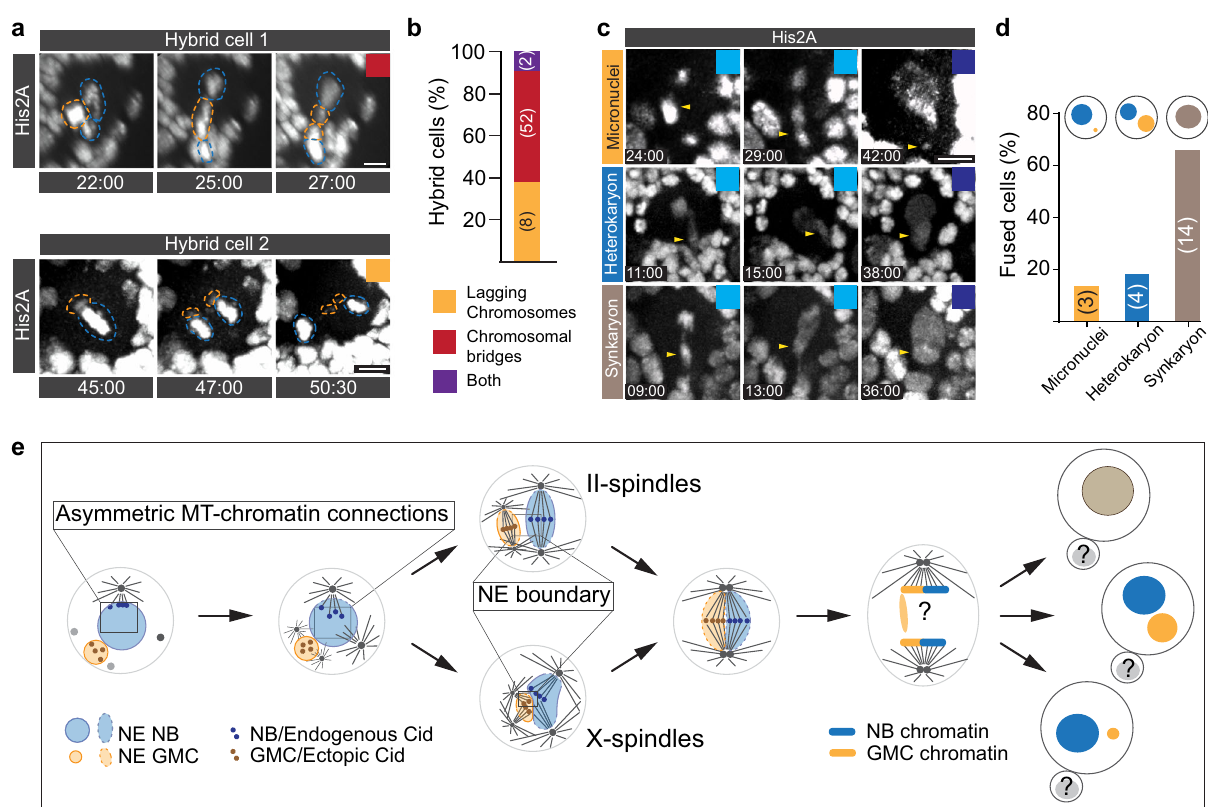
Fig. 7 Ectopic chromosomes in hybrid cells segregate erroneously. a Representative examples of delayed (top row) and simultaneous (bottom row) segregation of endogenous (blue dashed circle) and ectopic (orange dashed circle) chromosomes in wild type hybrid cells expressing the chromatin marker His2A::GFP. b Bar graph showing percentage of NB-GMC hybrid cells with lagging chromosomes, chromosomal bridges, or both. c Representative third instar larval NB-GMC hybrids expressing histone marker His2A::GFP showing missegregating chromatids (yellow arrowheads) during anaphase, resulting in micronuclei (top row), heterokaryon (middle row) or synkaryon (bottom row) formation. Time stamps are in relation to NEB ( = 0:00). d Bar graph quantifying the percentage of fused cells with micronuclei, heterokaryons or synkaryons. e Summary and model. Time in mins:secs. Scale bar is 5 μ